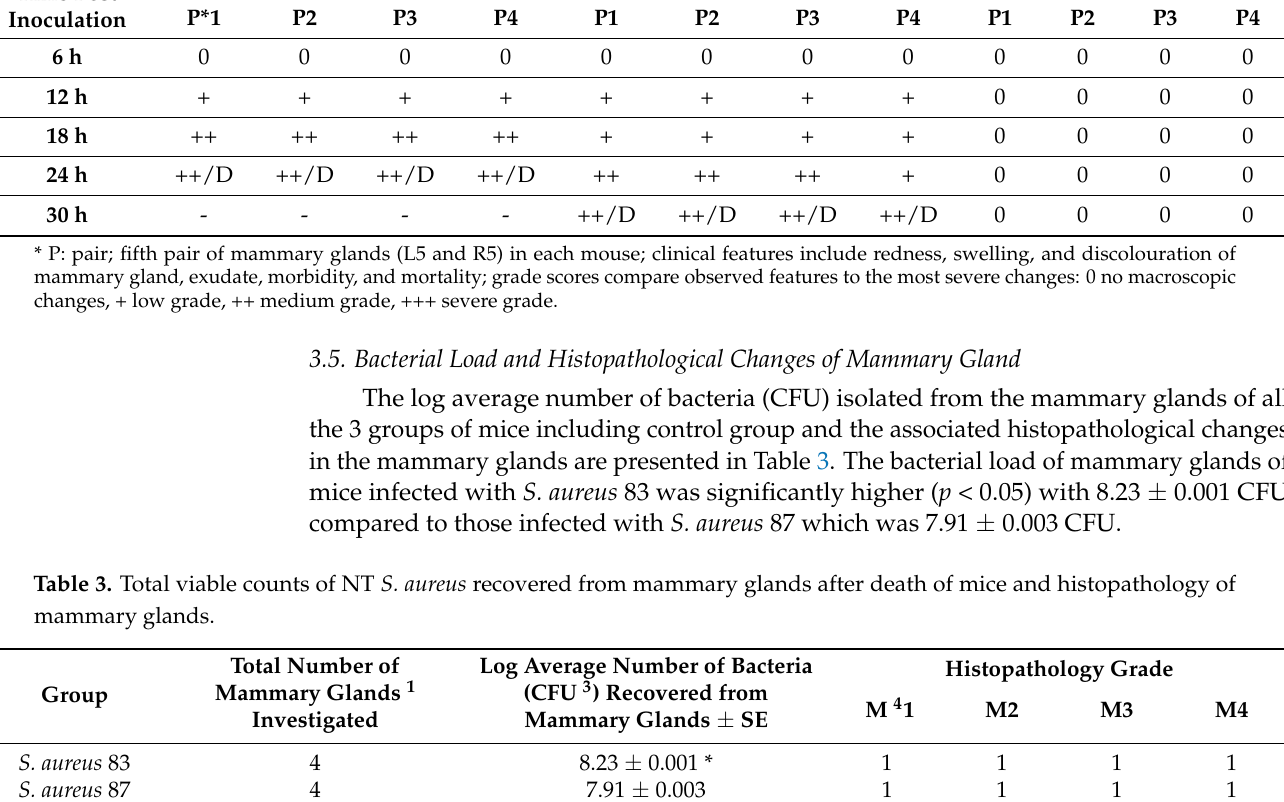
Table 2. Clinical signs observed in different groups of mice post-infection (observations up to 30 h post inoculation). Time Post Inoculation